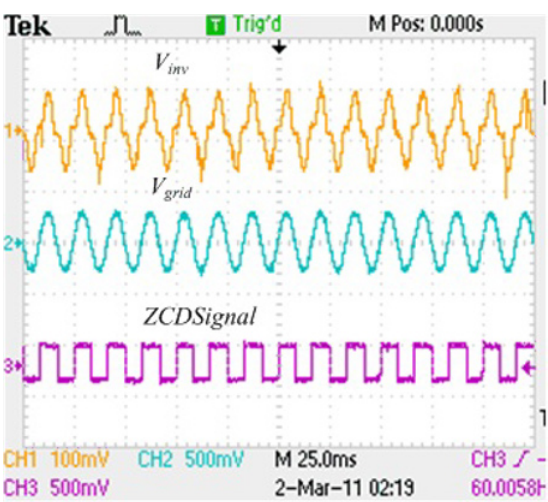
Figure 12. Voltage of inverter synchronized with AC line voltage